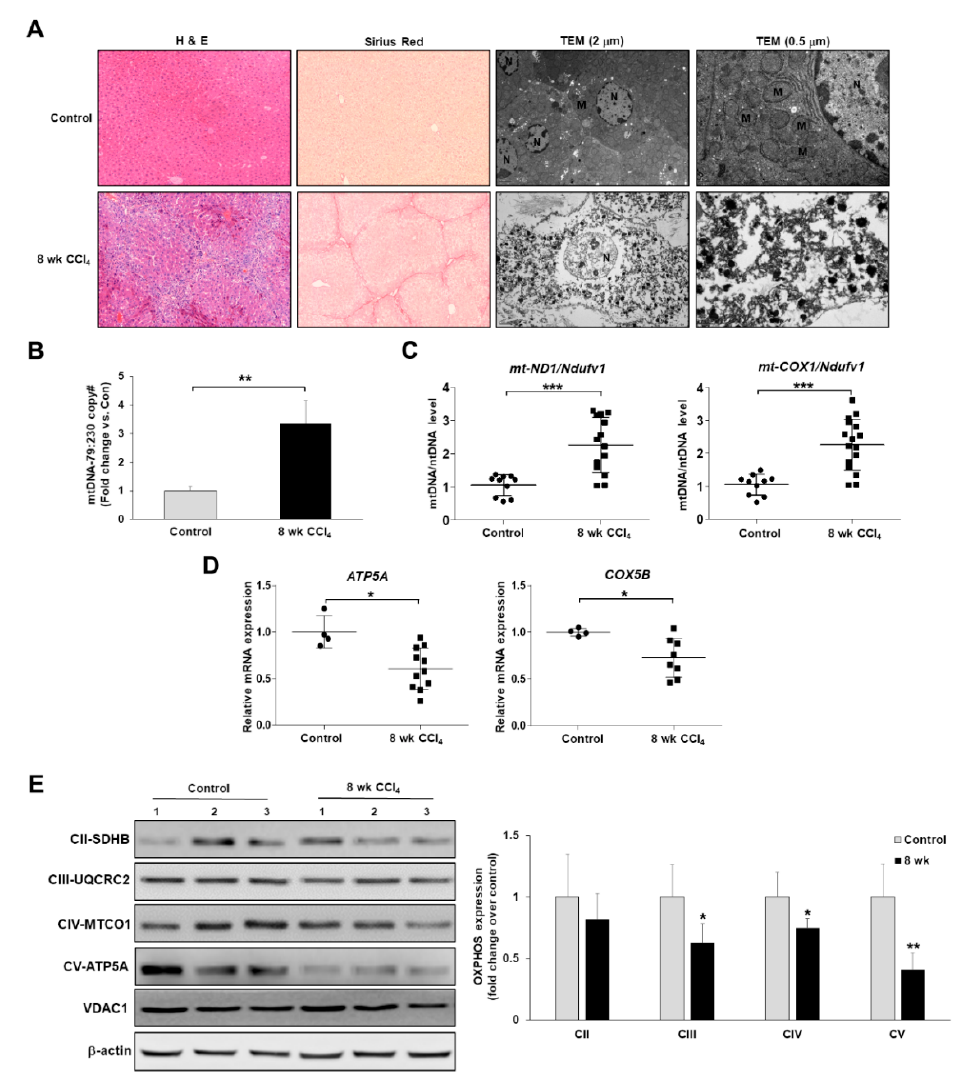
Figure 1. Morphological and functional abnormalities in mitochondrial are present in the mouse model of CCl 4 -induced liver fibrosis. Male BALB / c mice were injected intraperitoneally with CCl 4 biweekly for 8 weeks to establish a hepatic fibrosis mouse model. ( A ) Representative images of H&E and Sirius red staining (original magnification, X200) of liver sections. TEM analysis of hepatocyte showing nucleus (N) and mitochondria (M) (scale bar = 2 & 0.5 µ m). ( B ) Damaged mtDNA levels of the 79 bp fragment (damaged) and 230 bp fragment (undamaged) in gDNA isolated from livers of mice were assessed by qPCR. Bars represent mean copy number ratios of mtDNA-79:230, normalized to 18S levels. ( C ) Analysis of mtDNA content to obtain the mtDNA / nDNA ratio. gDNA isolated from livers of mice was analyzed by qPCR for the indicated genes. ( D ) Total RNA isolated from livers of mice was analyzed by qRT-PCR for the indicated genes. ( E ) Western blot analysis of representative subunits of OXPHOS complexes expression.